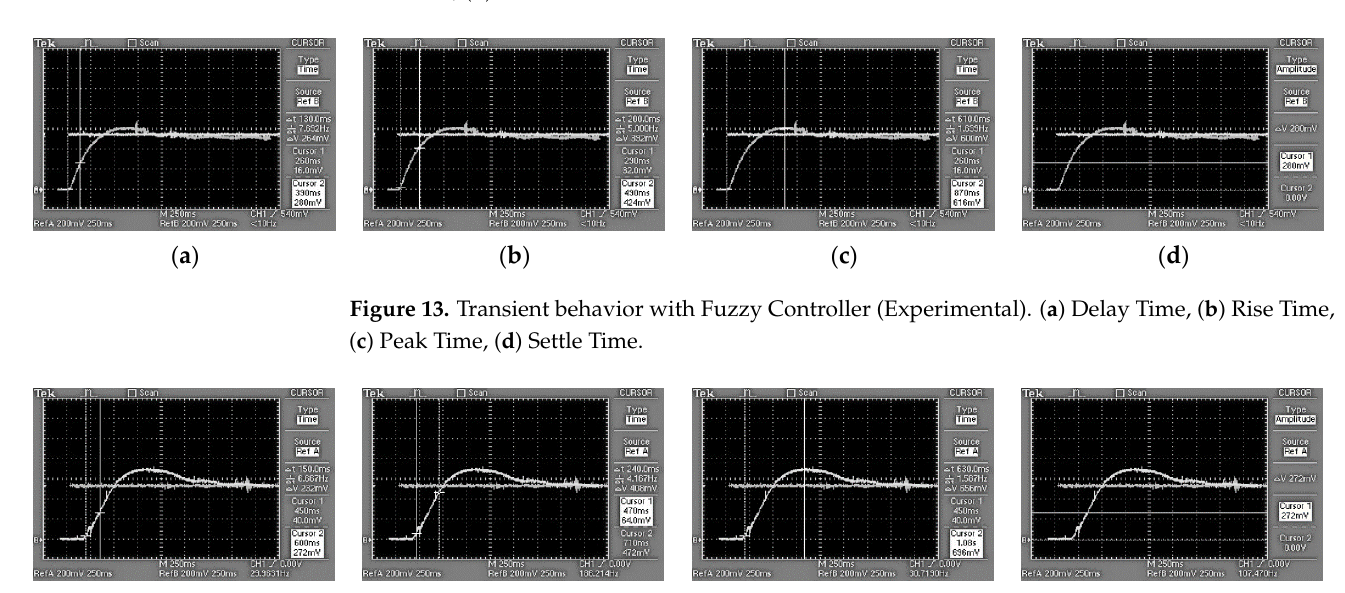
Figure 12. Transient behavior with PI controller (experimental). ( a ) Delay Time, ( b ) Rise Time, ( c ) Peak Time, ( d ) Settle Time.